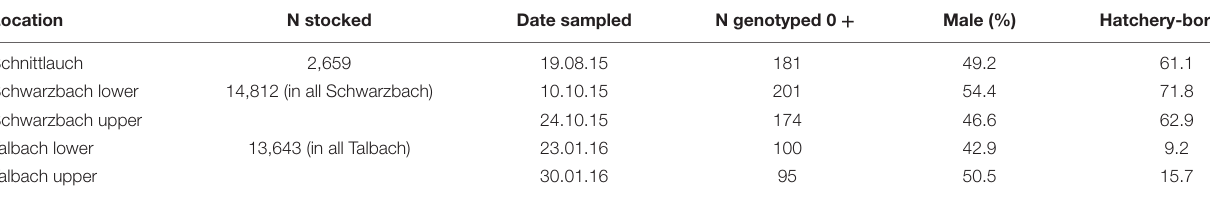
TABLE 1 | Summary details of the fish sampled in the field-based study.